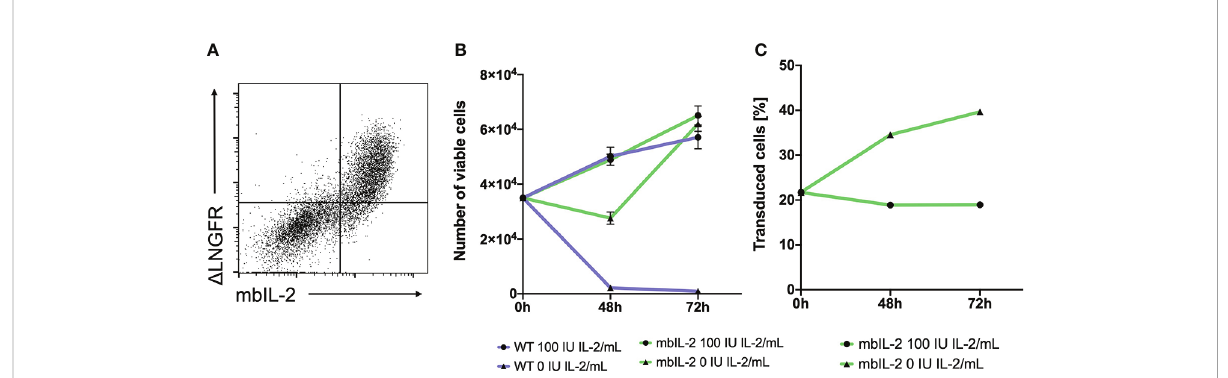
FIGURE 1 Anchorage of IL-2 to the cell surface led to stable, membrane-associated expression of the cytokine and mediated biological activity in CTLL-2 cells. (A) 293T cells were transfected with the mbIL-2 CAR vector plasmid to validate mbIL-2 surface expression. Representative dot plot con fi rmed coexpression of the D LNGFR CAR reporter gene and surface expression of mbIL-2. (B) The biological activity of mbIL-2 was assessed via the use of highly IL-2-dependent CTLL-2 cells. To address the possibility of autocrine IL-2 signalling, CTLL-2 cells were either transduced with mbIL-2 CAR or left untransduced (WT) and were cultured under IL-2-limiting conditions. Cultivation of CTLL-2 wild-type cells under IL-2- free conditions resulted in almost complete cell loss after 72 hours (9.2x10 2 +/- 4.0x10 2 ). The calculated number of mbIL-2 CTLL-2 cells (6.2x10 4 +/- 2.7x10 3 ) was comparable to that of CTLL-2 wild-type cells supplied with 100 U IL-2 (5.7x10 4 +/- 4.1x10 3 ). Culturing mbIL-2 CTLL-2 cells with 100 U exogenous IL-2 showed no negative effect on their cell growth (6.5x10 4 +/- 3.5x10 3 ). (C) The survival advantage of